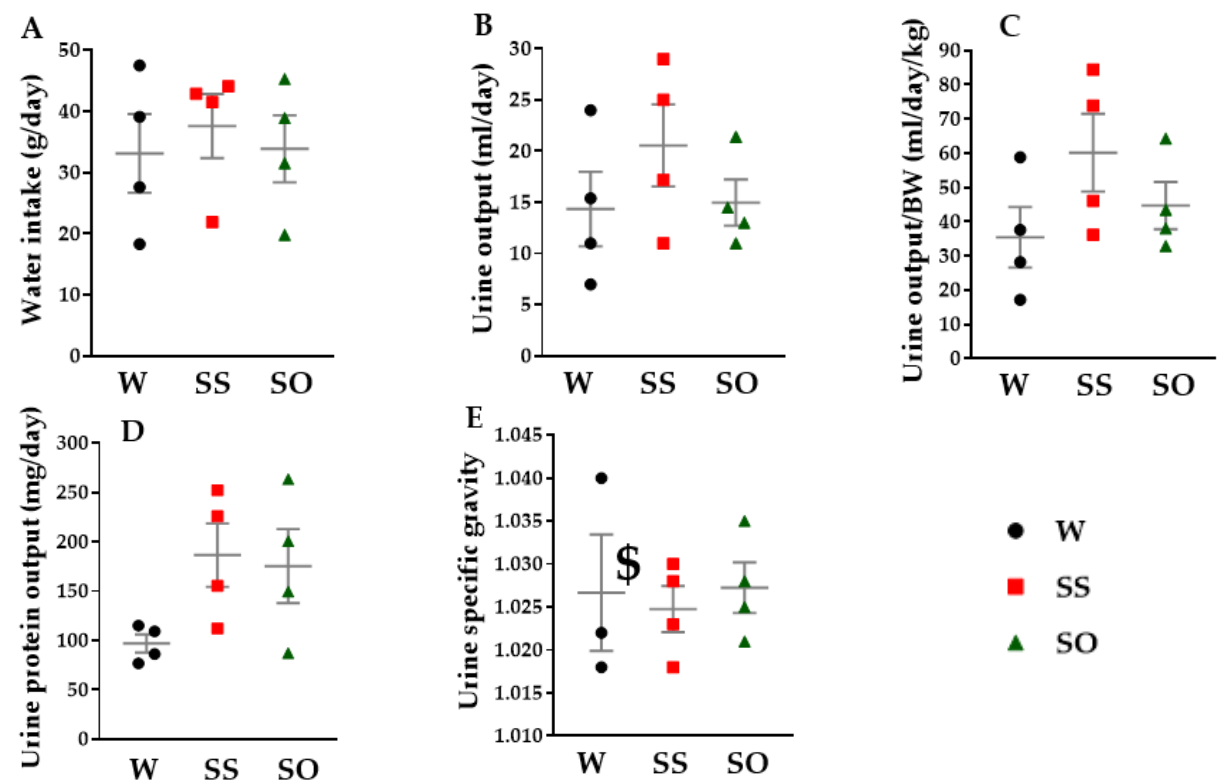
Figure 5. Effects of human omentin-1 on 24 h water intake and urine output in SHR. Male SHR (65–68-week-old) were subcutaneously injected with saline (0.14 mL/day, n = 4; SS) and human omentin-1 (18 µ g/kg/day, n = 4; SO) by using an implanted osmotic pump for 14 days. Male WKY were sham operated (n = 4; W). Urine was collected by placing rats in metabolic cages for 24 h. ( A ) Water intake (g/day), ( B ) urine output (ml/day), ( C ) urine output/body weight; BW (mL/day/kg), and ( D ) urine protein output (mg/day) were calculated. Urine protein concentration (mg/mL) was measured with a BCA Protein Assay. ( E ) Urine specific gravity was measured with a urine gravity meter (n = 3). $ One sample was over the measurement limitation. Results were expressed as means ± S.E.M. Statistical evaluations were performed using a One-way ANOVA followed by Bonferroni’s post-hoc